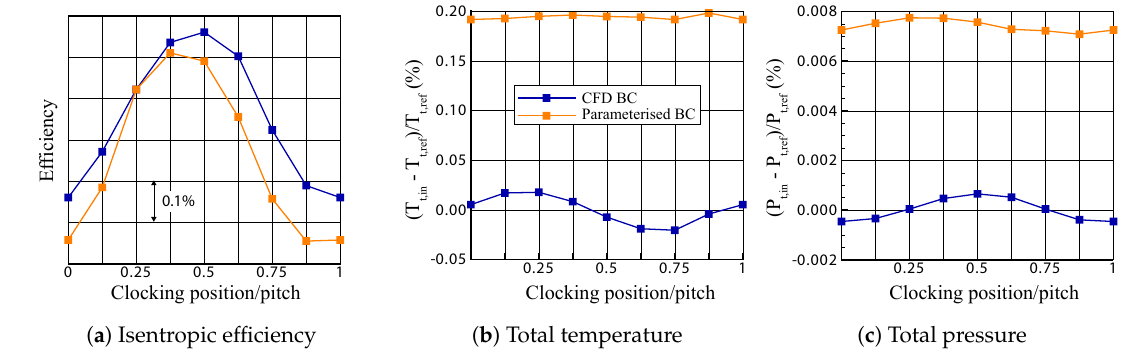
Figure 11. Isentropic stage efficiency and inlet